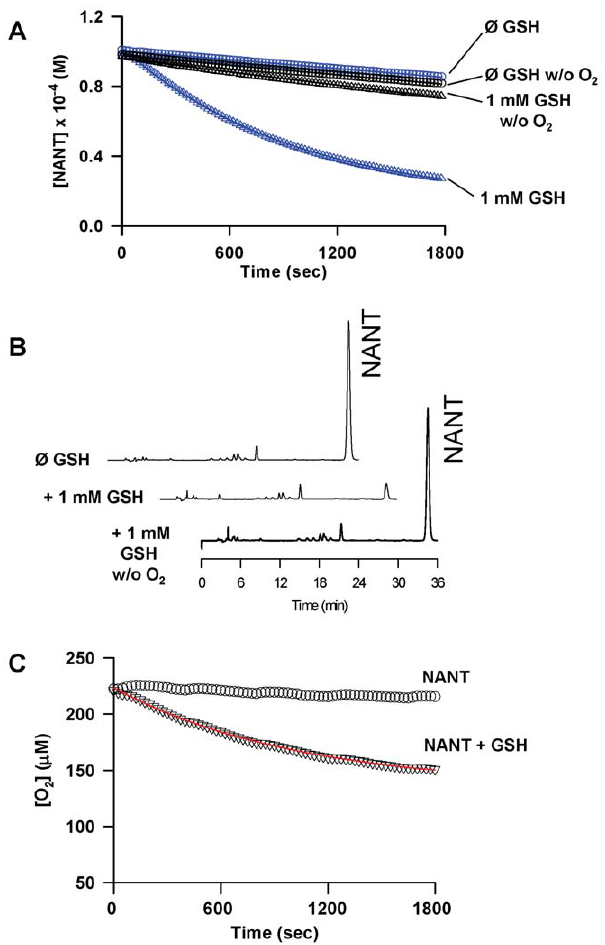
Figure 2. The denitrosation of N-acetyl-nitroso-Trp (NANT) by glutathione (GSH) requires molecular oxygen. ( A ), Time-course of GSH-induced NANT decomposition in the presence or absence of molecular oxygen; representative of at least 4 experiments. ( B ), Representative chromatogram (detection at 335 nm) obtained from the reaction of 100 m M NANT with 1 mM GSH and O 2 . Chromatograms are representative of three independent experiments. ( C ), Time-course of O 2 consumption in the presence of 100 m M NANT and 1 mM GSH; representative of 4 experiments. The solid lines represent the nonlinear regression fitting of data points (open symbols).